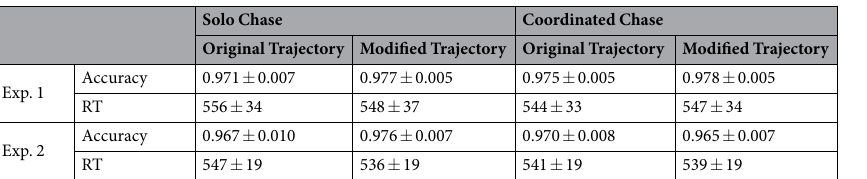
Table 1. Accuracy and reaction times (ms) for all conditions (mean ±